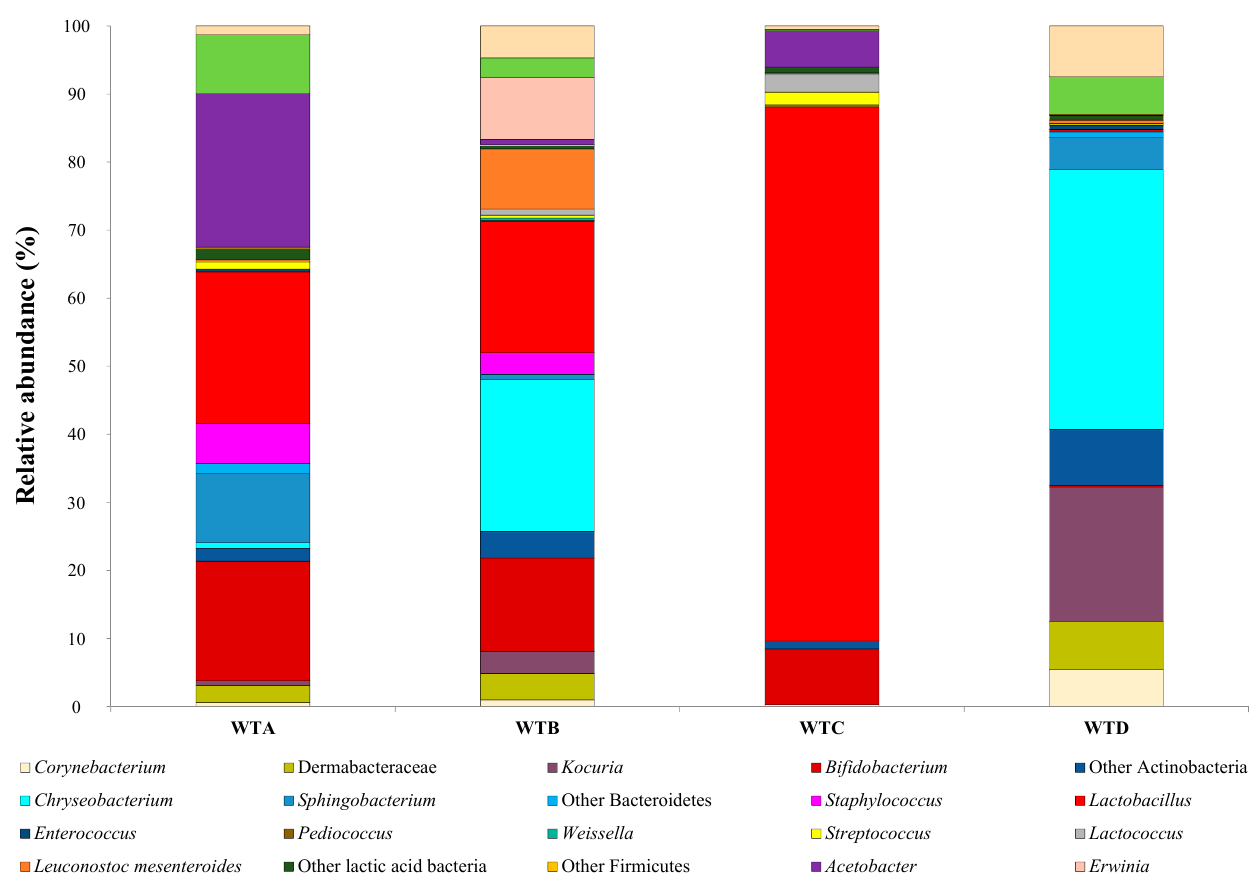
Figure 3. Relative abundances (%) of bacteria identified by MiSeq Illumina in wooden table biofilms. Abbreviations: WT, wooden table; A–D, dairy factory A–dairy factory D.